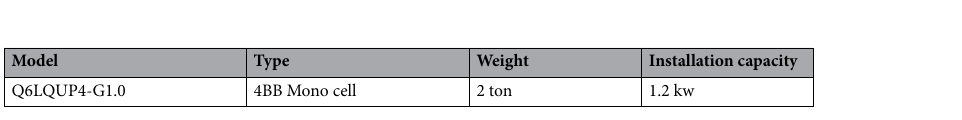
Table 2. Detailed specification of a solar tree donated by Hanwha Q CELLS Korea.